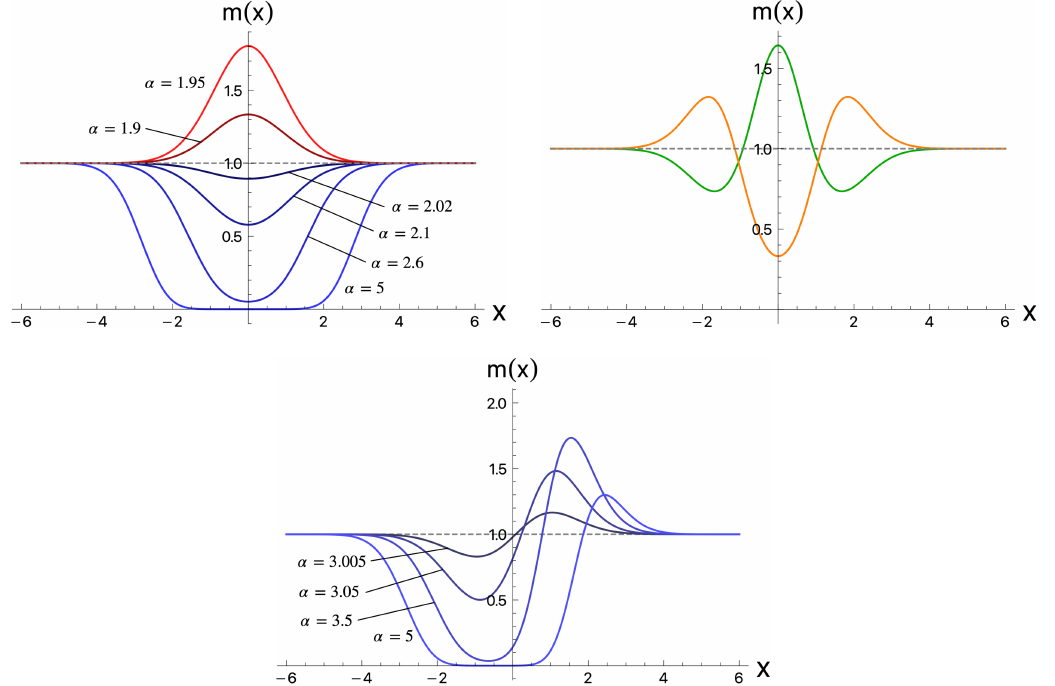
Figure 4 . Solution profiles for deformed funnels. The above left panel shows the profiles for the first even branches, i.e., ditches ( m (0) < 1 ) and bulges ( m (0) > 1 ). The above right panel shows the second even branches at α = 4 . 05 . The panel below is the first odd branch. Due to the small values of m , the profiles for large α = 5 resemble double